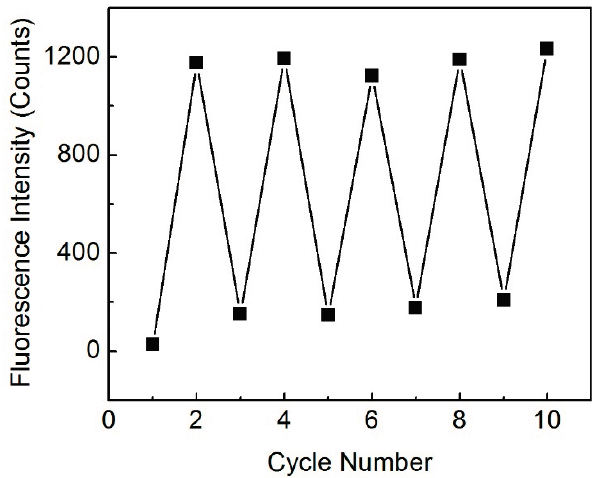
Figure 3. Cycling measurement of 6 nM R6G and ultrapure water.